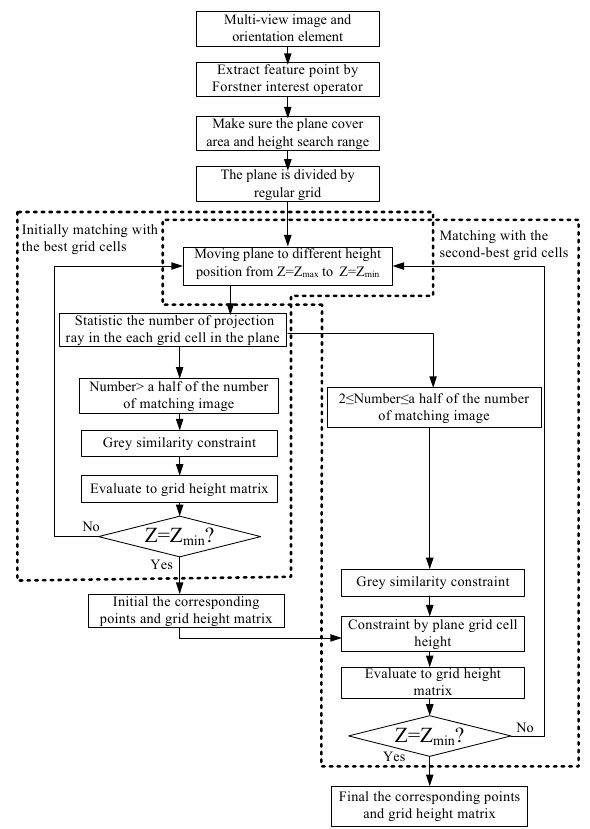
Figure 2. Flow chart of the overall